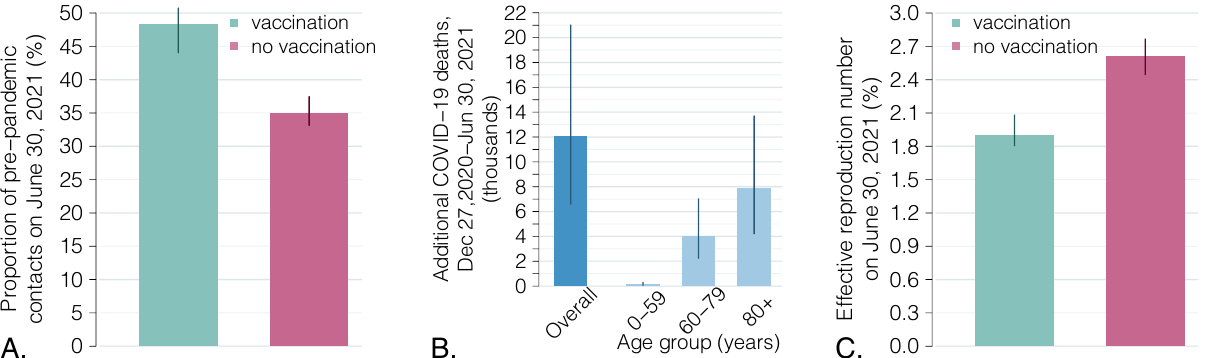
Fig. 2 Impact of the vaccination program during the fi rst half of 2021. A Estimated active social contacts on June 30, 2021, as a proportion of pre- pandemic contacts, with and without a vaccination program, under the constraint that the two scenarios reproduce the same observed epidemic trajectory. Bars: mean estimates; vertical lines: 95% CI; n = 300 stochastic model realizations. B Number of additional COVID-19 deaths between December 27, 2020, and June 30, 2021, total and by age group, under a no-vaccination scenario. Bars: mean estimates; vertical lines: 95% CI; n = 300 stochastic model realizations. C Effective reproduction number (i.e., under complete resumption of pre-pandemic contacts) on June 30, 2021, with and without vaccination. Bars: mean estimates; vertical lines: 95% CI; n = 300 stochastic model realizations.